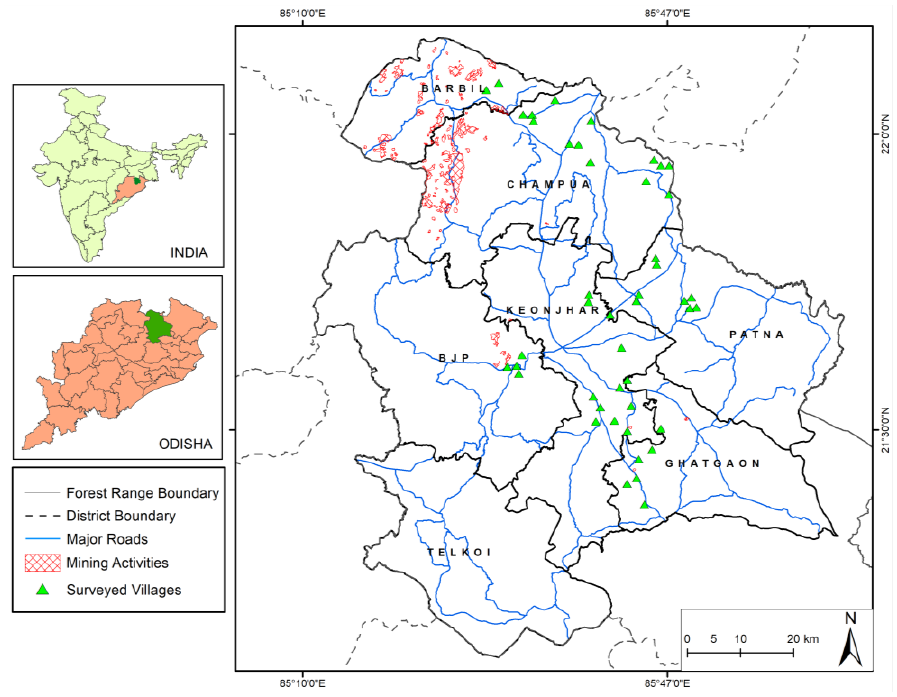
Figure 1. Location of the study area in the Keonjhar forest division, eastern India. Green triangles indicate villages where telephone interviews were conducted.